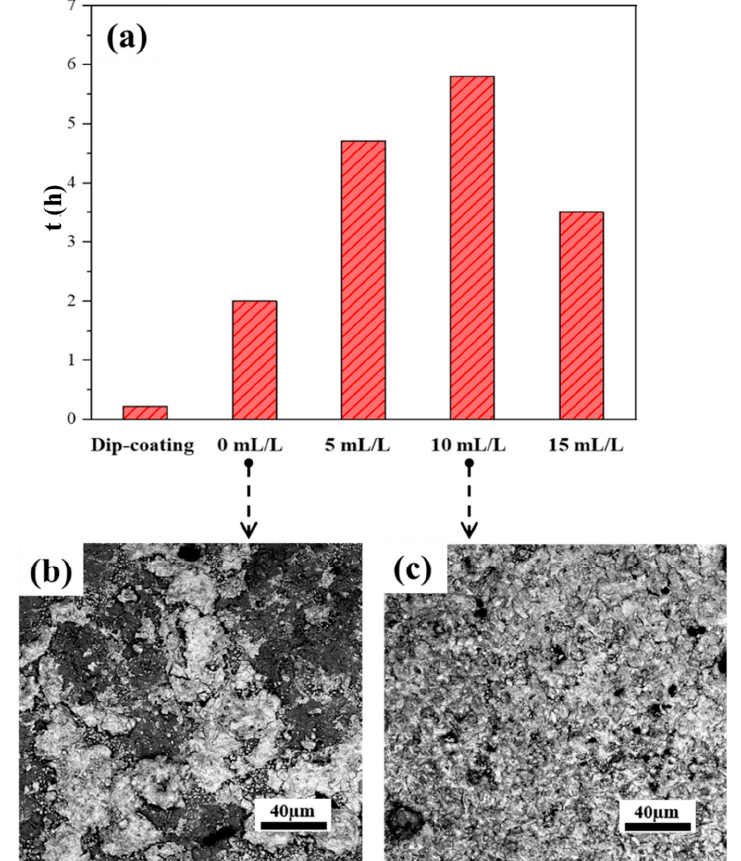
Figure 7. The accelerated service life results, ( a ) the tested accelerated service life for samples preprepared by dip-coating and sol-enhanced electrodeposition with different TiO 2 sol concentrations, ( b ) surface morphology of electrodeposited Ti/SnO 2 -Sb 2 O x after 2 h test, and ( c ) surface morphology of Ti/SnO 2 -Sb 2 O x -TiO 2 (10 mL/L TiO 2 sol doped) after 2 h test.